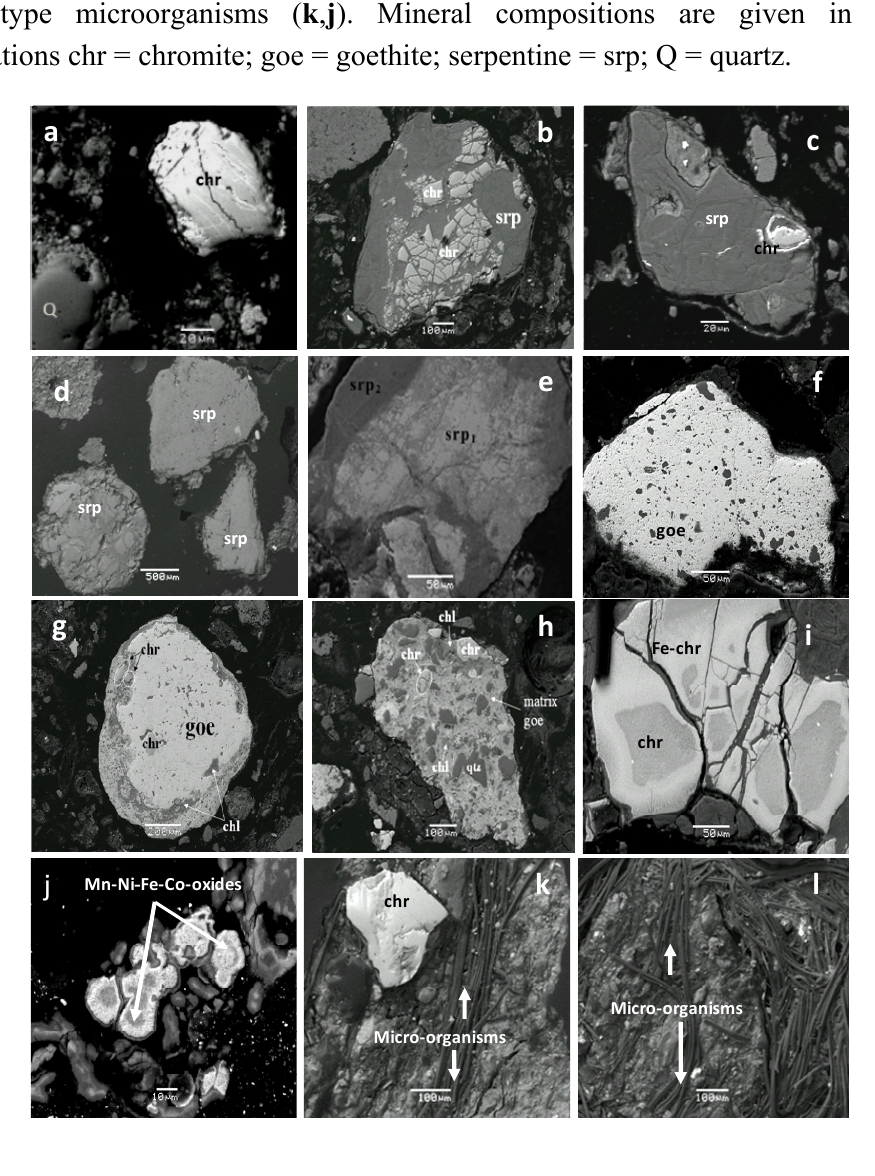
Figure 3. Selected backscattered images from the Assopos-Thiva basins and central Evia soils, showing rounded and angular fragments of chromite ( a – c , g – i , k ), goethite ( f – h ), Mn-Ni-Fe-Co-oxide and silicate intergrowths ( j ), serpentine ( b – e ), quartz ( a ) and filament-type microorganisms ( k , j ). Mineral compositions are given in Table